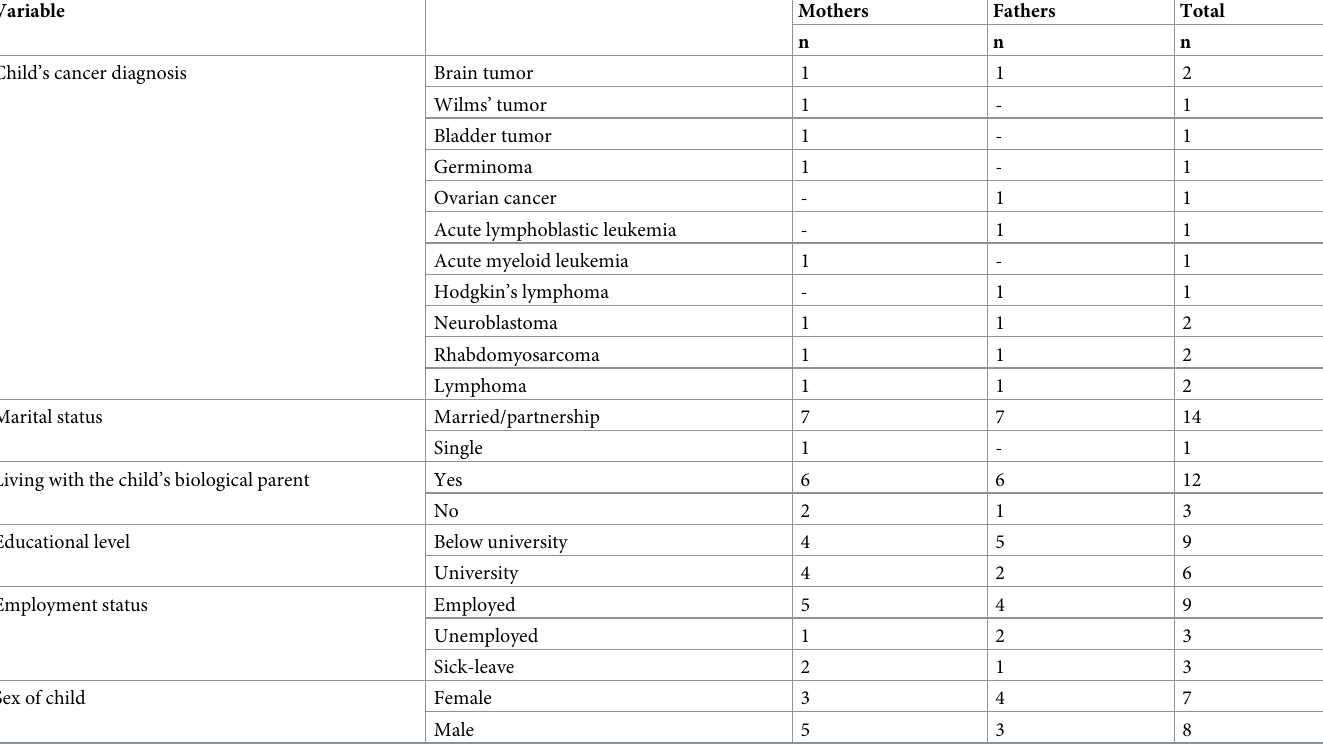
Table 2. Background characteristics of mothers (n = 8) and fathers (n = 7).